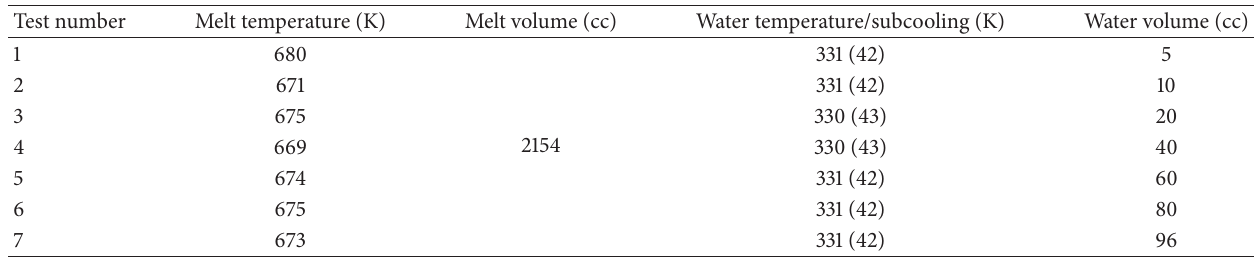
Table 2: Condition of experimental tests performed